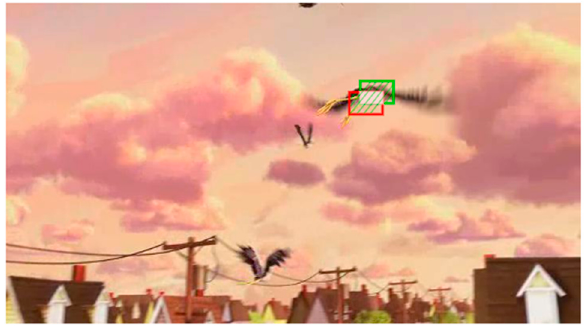
Figure 9. Visual presentation of the process of computing overlapping area